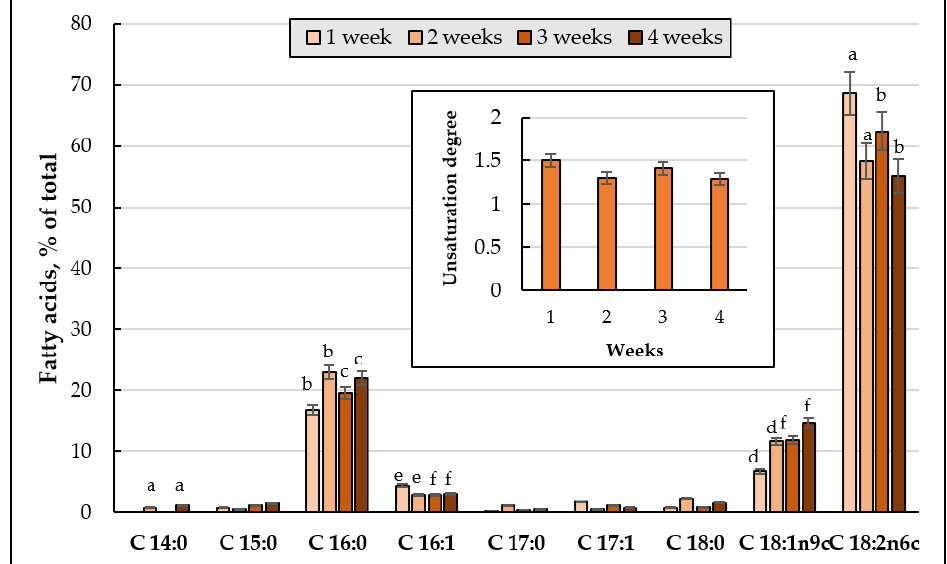
Figure 9. Fatty acid composition of the main membrane phospholipids of E.magnusii (% of total amount) using 0.2% glucose. In the cut-in, there is the degree of unsaturation of FAs of the phospholipids. Mean values are displayed (n = 3, ±SD). a— p < 0.04; b— p < 0.01; c— p < 0.001; d, e— p < 0.02; f— p < 0.002.